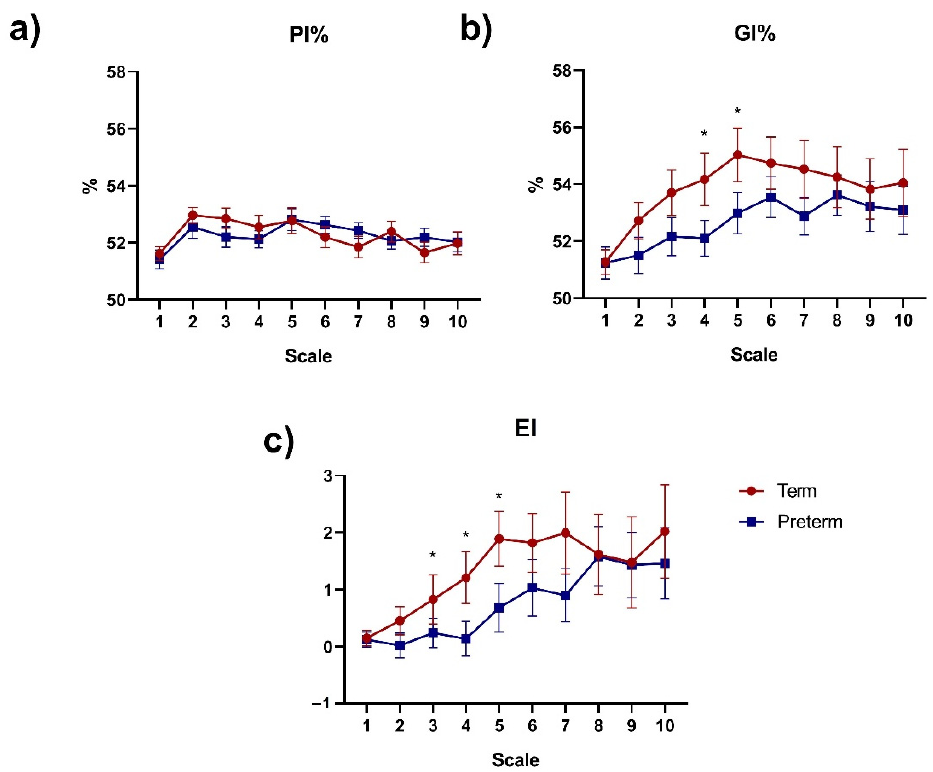
Figure 3. Error bar (mean ± SEM) of multiscale asymmetry indices of fetal beat-to-beat R-R intervals time series using ( a ) Porta (PI%); ( b ) Guzik (GI%); and ( c ) Ehlers (EI) at lags τ = 1–10 for Preterm and Term groups. * p < 0.05 between Term and Preterm (unpaired t-test or Mann–Whitney test).